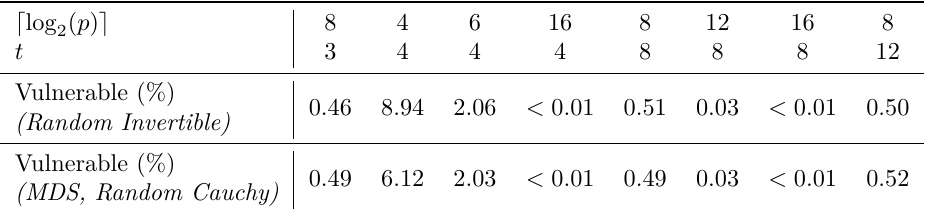
Table 1: Percentage of vulnerable matrices for Algorithm 1 and orders t , when considering prime fields F . p